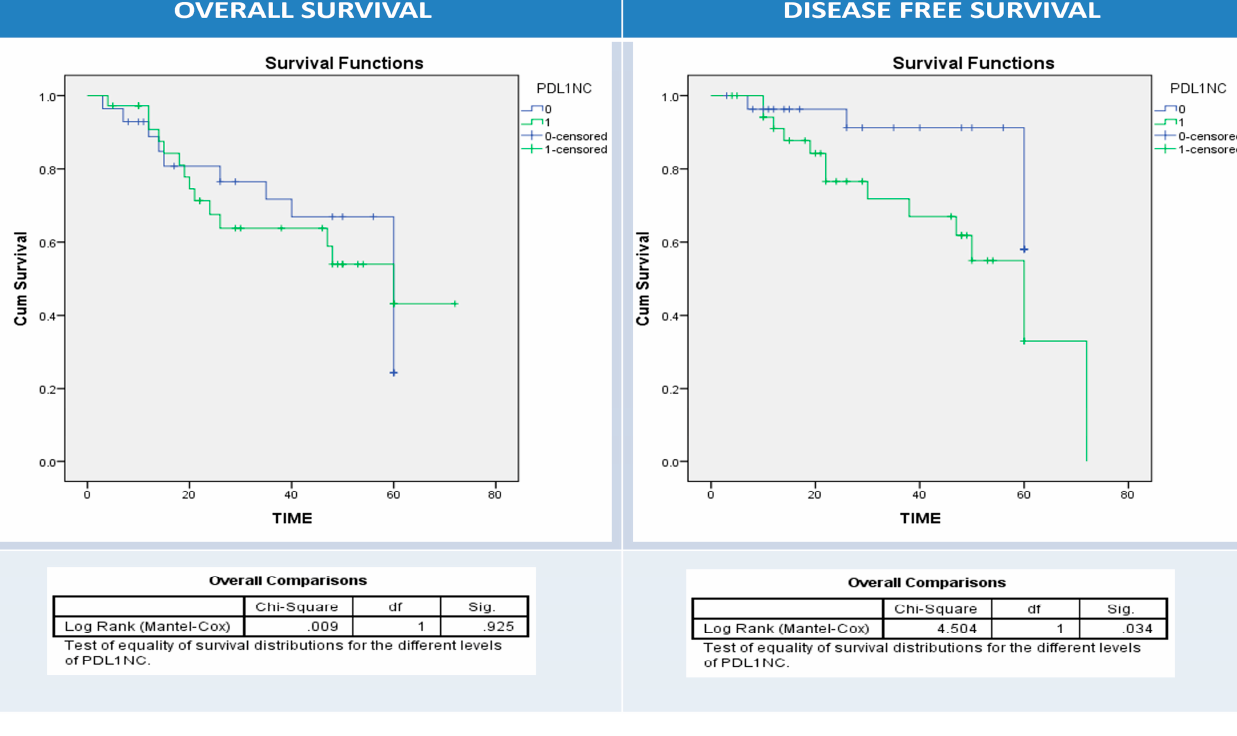
Figure 7. Kaplan–Meier survival curves for overall (right panel) and disease-free survival (left panel) according to neoplastic cells (NC) PDL1 expression (0: blue (-ve PDL1 NC); 1: green (+ve PDL1 NC)). Log Rank test (Mantel–Cox) was used.